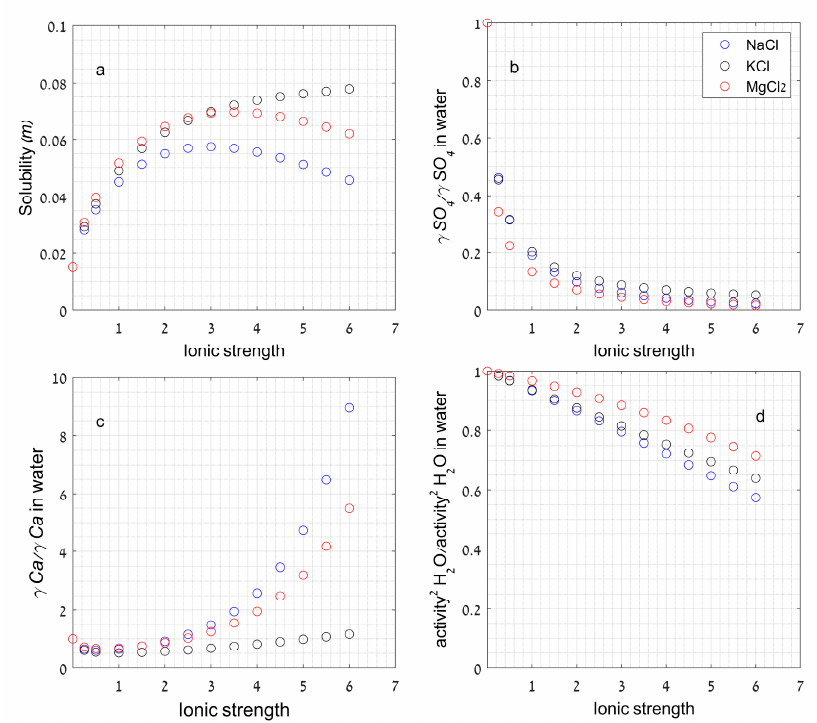
Figure 3. The calculated solubility ( a ) and ratio of γ SO 42 − ( b ), γ Ca 2+ ( c ), and a 2 H 2 O ( d ) in pure water and in electrolyte solutions up to I = 6 m with Ca 2+ :SO 42 − = 1. Calculations were performed with Pitzer.dat database in PHREEQC 2.18. The ionic strength is derived from either NaCl (circles), KCl (triangles) or MgCl 2 (squares) and does not include the contribution of the dissolved Ca 2+ and SO 42 − . At a given ionic strength, the solubility of gypsum depends on the background elec- trolytes. With increasing salinity, both γ SO 42 − and 𝑎 (cid:2870) 𝐻 (cid:2870) 𝑂 decrease. On the other hand, γ Ca 2+ shows an initial decrease in the low salinities followed by a large increase if Na + or Mg 2+ , which are the matrix cations in solution. This increase is also contrary to the effect